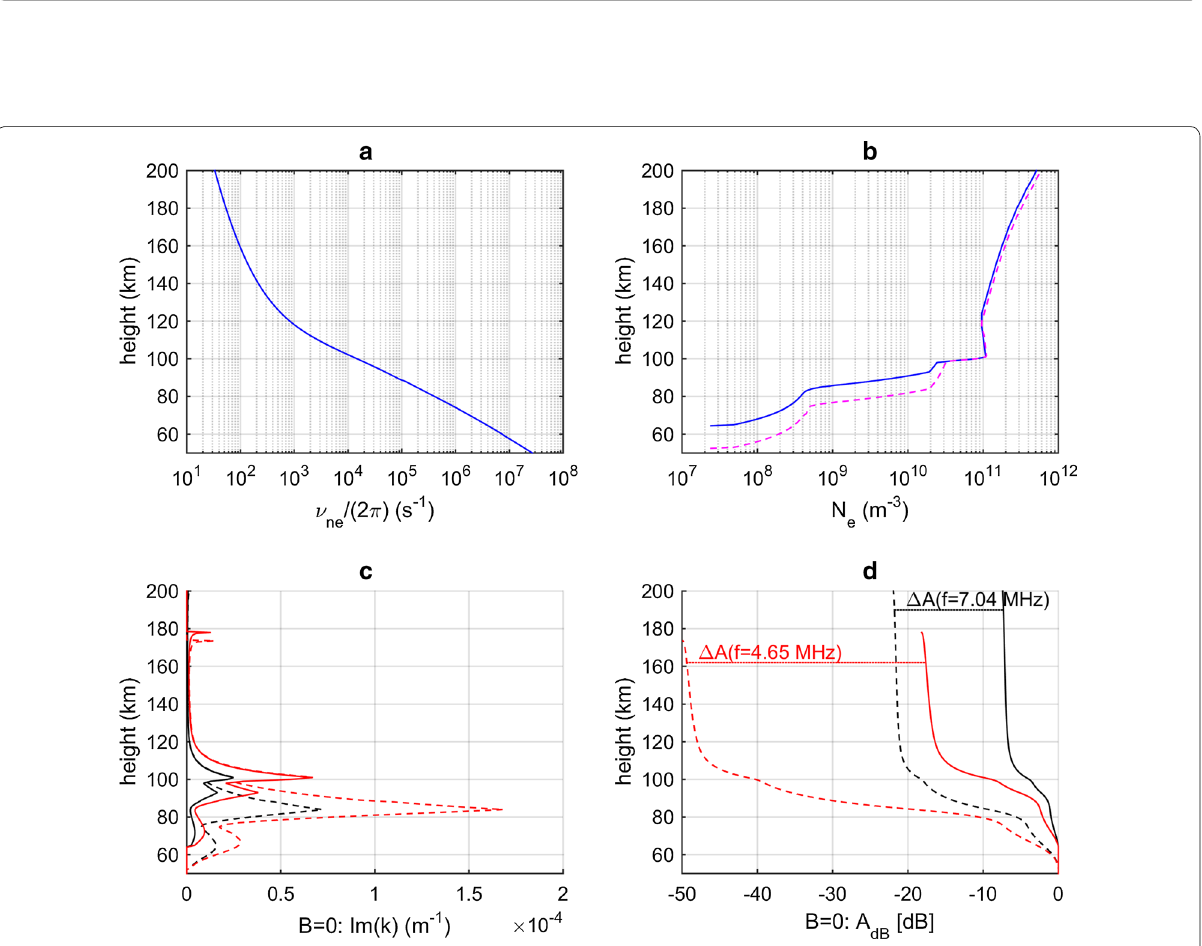
Fig. 7 Estimating attenuation in the Czech Republic on 22 October 2014. Solid lines represent modeled values before solar flare event at 14:00 UT and dashed lines the values during solar flare event a electron–neutral collision frequency ν/(2π) as a function of height. b Electron density as function of height. c Imaginary part of wave vector as a function of height for B attenuation A in dB considering propagation up and down for f